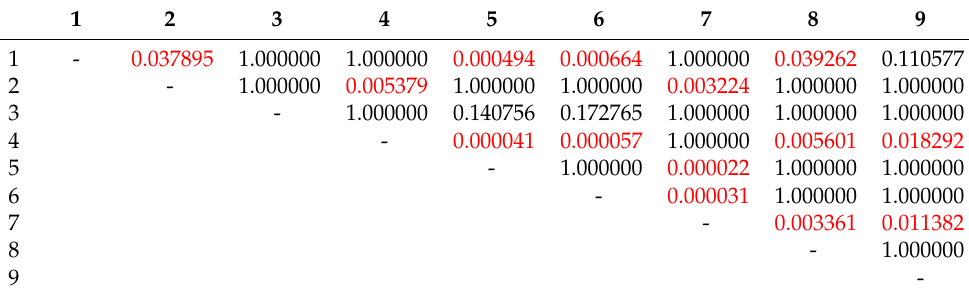
Ageing protocols: control-water, 24 h, 37 ◦ C; thermocycling + NaOH-water, 7500 thermo cycles, 5/55 ◦ C and 0.1 M NaOH, 7 days, 60 ◦ C; 5d water + NaOH-water, 5 days, 55 ◦ C and 0.1 M NaOH, 7